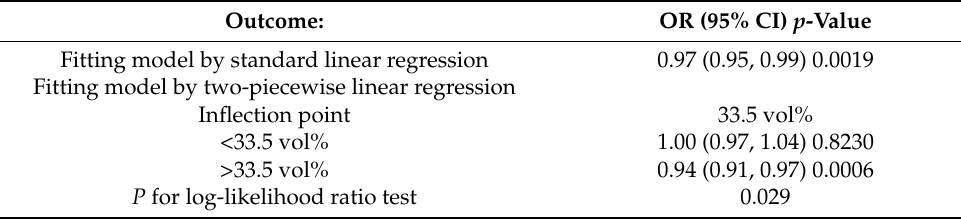
Figure 3. Curve fitting between admission hematocrit levels and preoperative DVT. Adjusted for sex, dementia, and multiple injuries. Table 4. Nonlinearity of admission hematocrit levels versus preoperative DVT (N = 1840). Outcome: OR (95% CI) p -Value Fitting model by standard linear